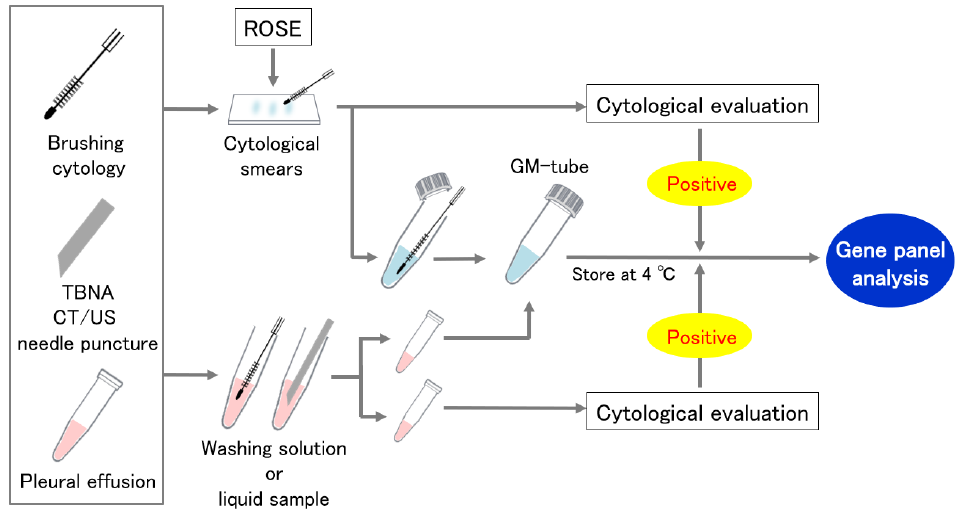
Figure 1. Cytological specimen collection using a GM tube. ROSE: Rapid on-site cytologic evaluation.